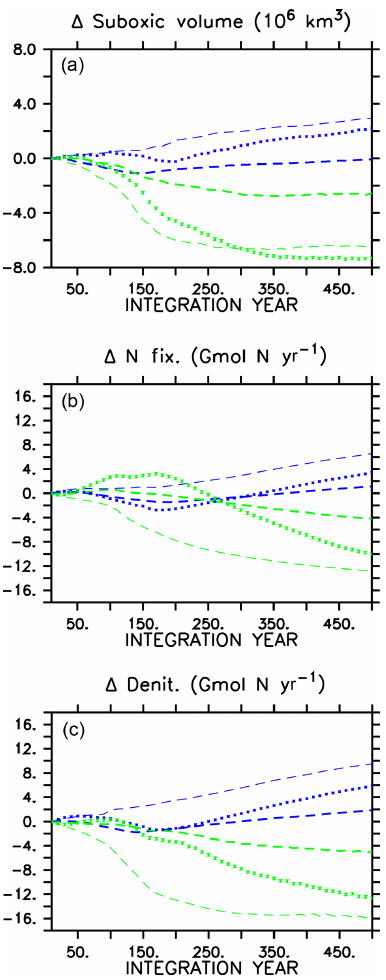
Figure 3. Change in globally integrated suboxic volume in WARM- ING icehouse (blue) and COOLING greenhouse (green) exper- iments (a) . Change in globally integrated nitrogen fixation (b) . Change in globally integrated denitrification (c) . Dotted lines rep- resent the MIXED model, thin dashed lines represent the NO- CACO3TR model, and thick dashed lines represent the CAL